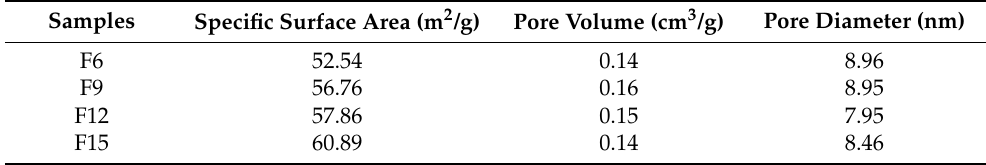
Table 2. Structural parameters of